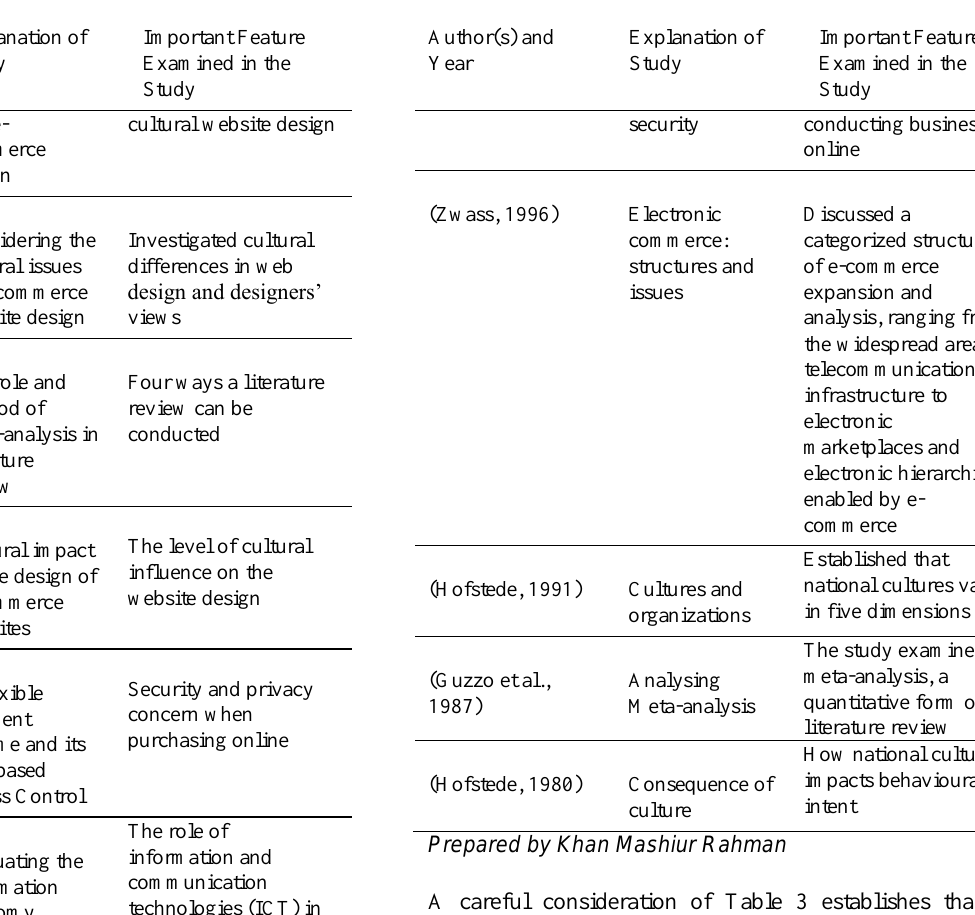
Table 3: A Summary of Selected Studies in Culture,